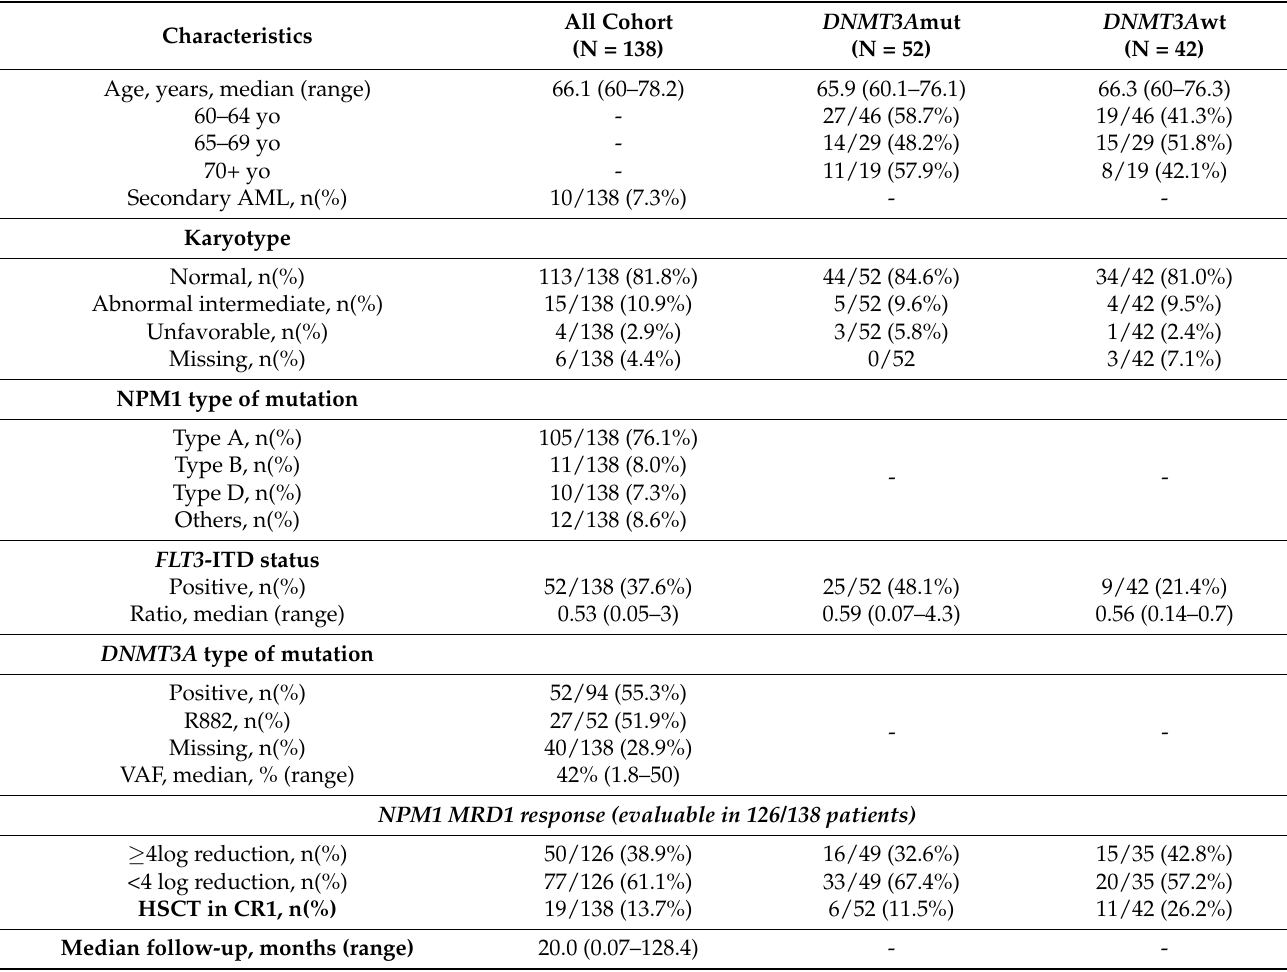
Table 1. Patient